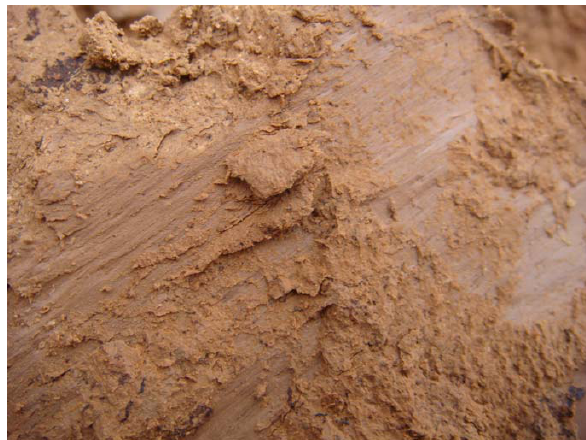
northern old slide was reactivated, and thus eight recent landslides were present as 241 shown in Fig. 4. As observed in the field investigation, the land utilization for 242 irrigation and undercutting of toes by river erosion made major contribution to the 243 reactivation of these masses. For the other two old slides, the average gradient of 244 landslides was about 20 º after movement had ceased. Lots of small cliffs had formed 245 within it, sometimes due to cultivation, so that the slide masses were still extremely 246 loose. Heavy seasonal rainfall resulting in saturation at the base caused by continuing 247 Fig. 7. Geological cross-section through the Liujiaquan landslides. seepage can lead to renewed triggering of the whole landslide body.